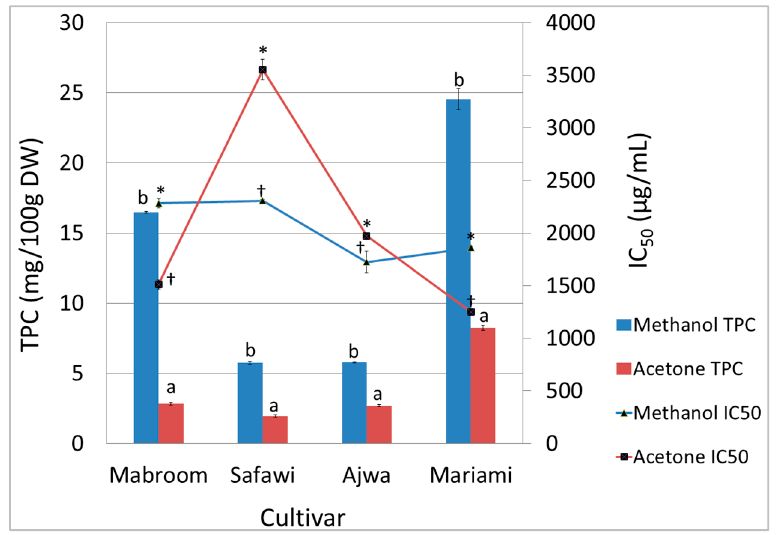
Figure 1. Effect of extraction solvent on TPC (mg GAE/100 g DW) and IC 50 ( μ g/mL) of different P. dactylifera cultivars. Values are the mean ± standard error of a minimum of three samples. The mean with different letters or symbols differs significantly at p < 0.05 (subject to different cultivars).